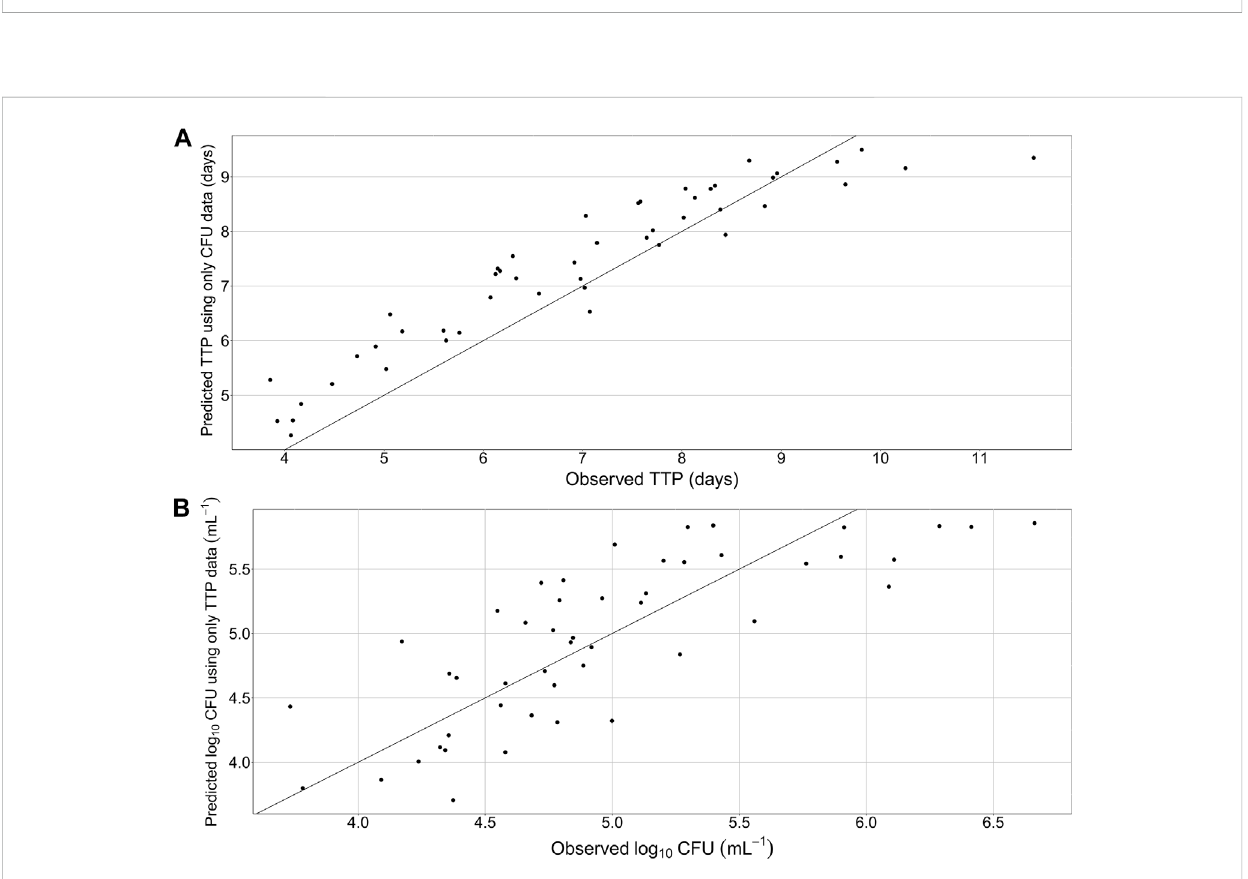
Predicted median tendency of the observed time-to-positivity (TTP) versus observed TTP, using only colony forming unit (CFU) data and the fi nal quantitativebiomarkermodel (A) andpredictedmediantendencyoftheobservedCFUversusobservedCFU,usingonlyTTPdataandthe fi nalquantitative biomarker model (B) . Solid line is the line of